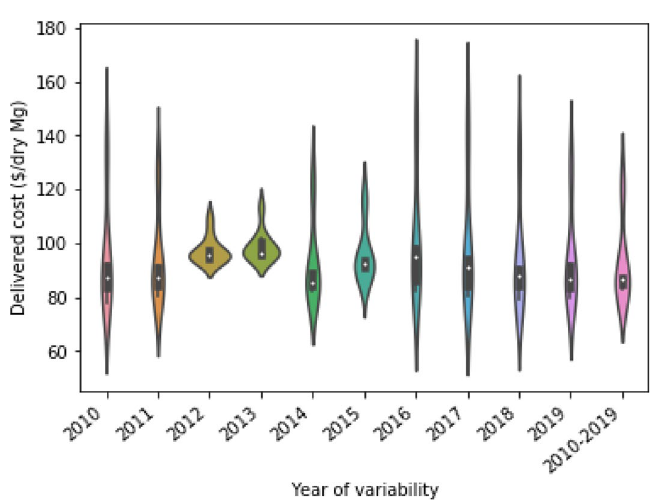
Figure 3. Variability in delivered